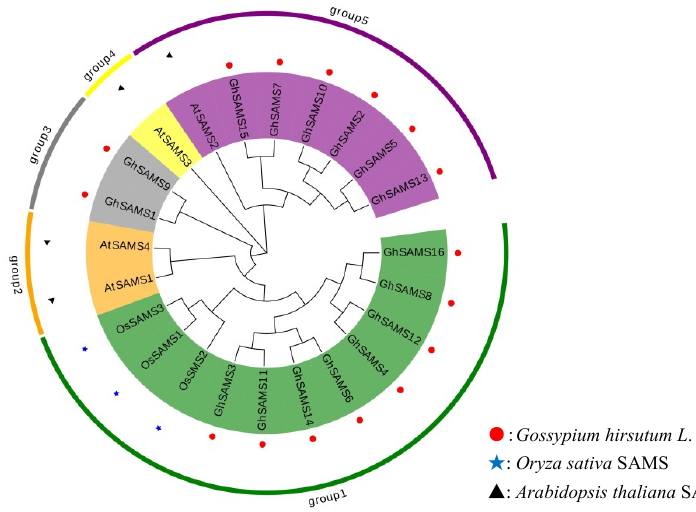
Figure 1. Phylogenetic analysis of SAMS genes in cotton, Arabidopsis and Oryza sativa.